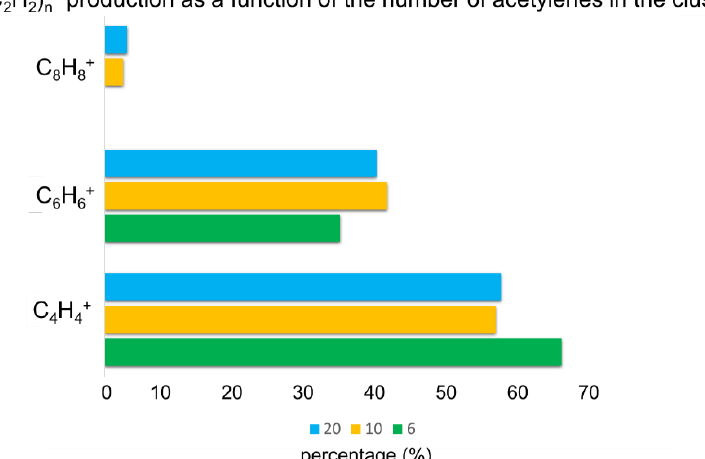
Figure 6. Histogram of the percentage of (C 2 H 2 ) n+ n = 2–4 bonded structures obtained upon ionization of the clusters as a function of the number of acetylene molecules in them. Percentages for six acetylene molecules were taken from the literature [38]. The percentages for 10 and 20 acetylene molecules correspond to the results in the present work.